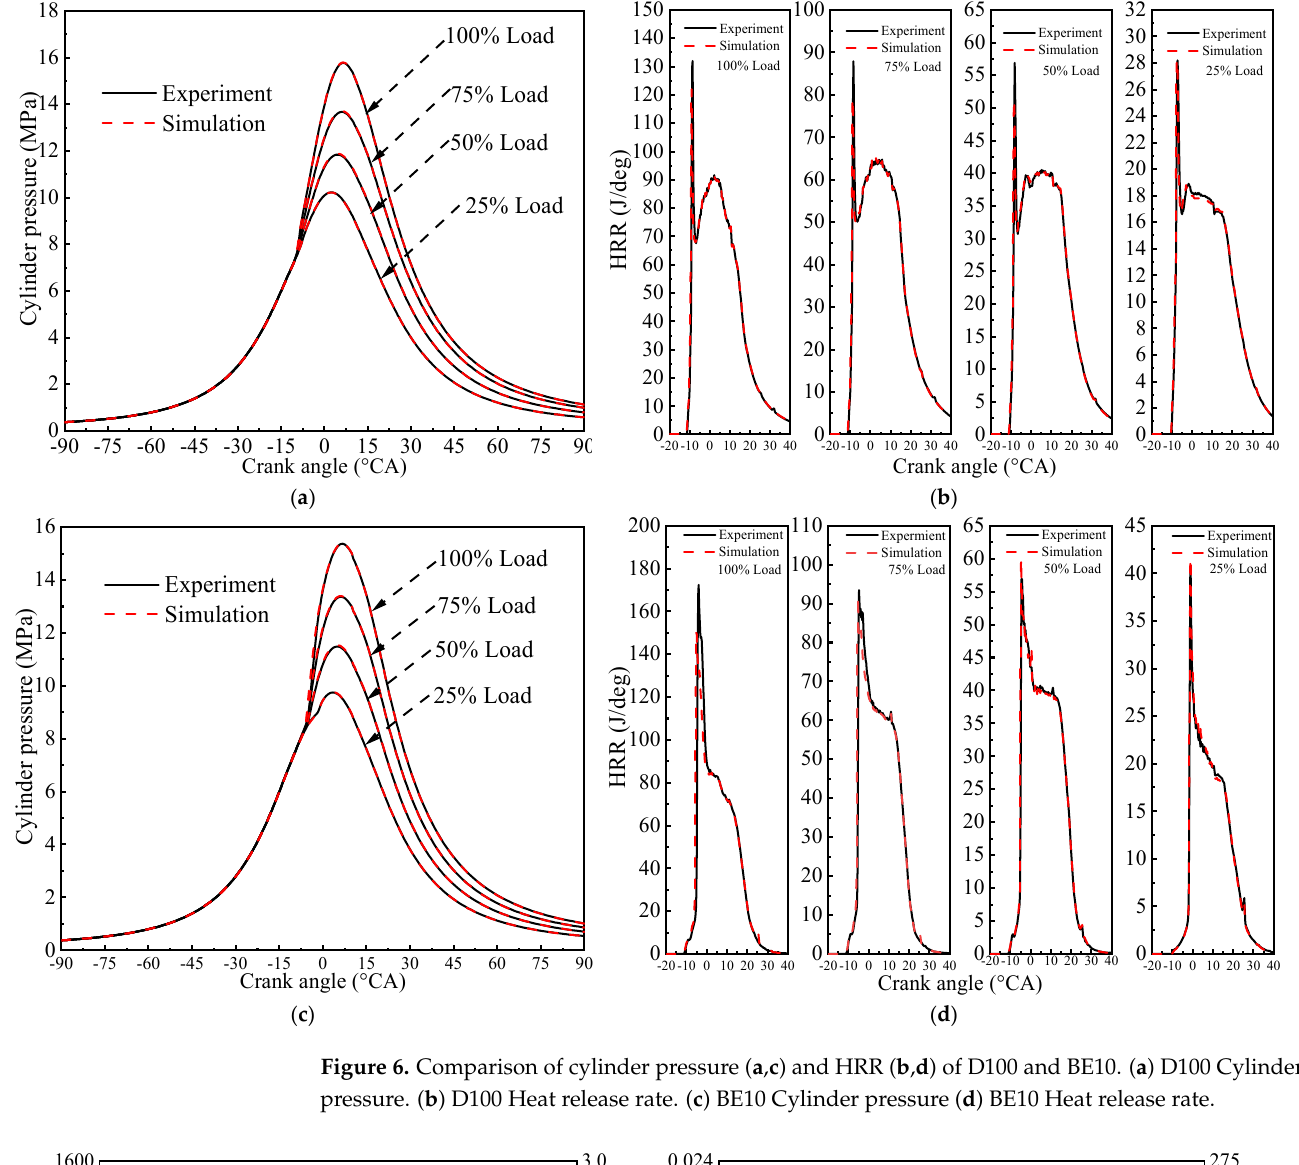
Figure 6. Comparison of cylinder pressure ( a , c ) and HRR ( b , d ) of D100 and BE10. ( a ) D100 Cylinder